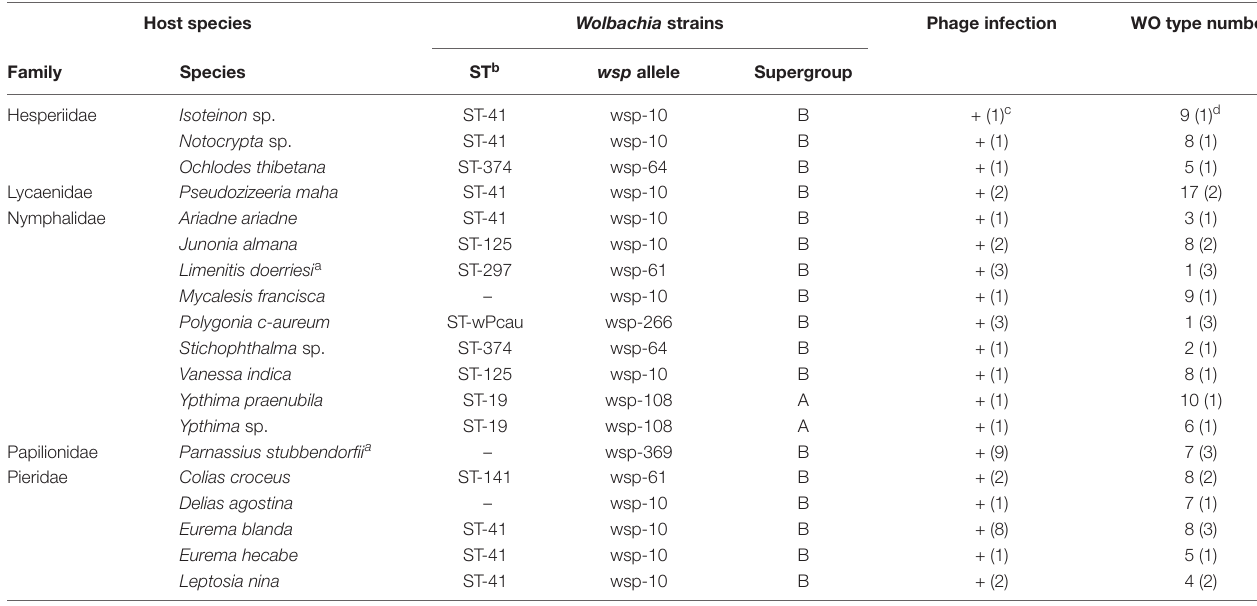
TABLE 1 | Wolbachia strains and phage WO types in